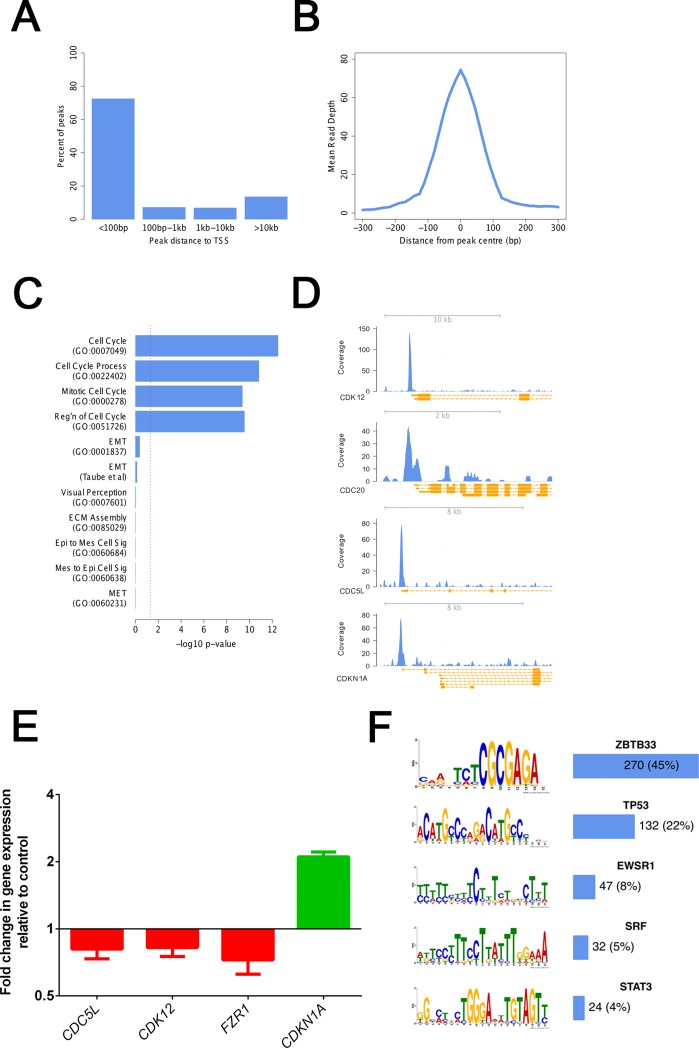
FOXM1 binds to promoters of proliferation associated genes.A. Percentage of FOXM1 peaks within proximity boundaries to Transcription Start Sites (TSS). B. Plot showing the mean read depth over FOXM1 peaks with a majority of binding within 100bp of peak centres. C. Protein coding genes with a FOXM1 peak within 1kb of TSS are highly enriched for GO categories relevant to cell cycle related functions but not EMT, MET, epithelial or mesenchymal related functions. In addition to the GO category, enrichment was also tested at a published EMT gene signature [55] with no significant binding seen. Enrichment was calculated using a hypergeometric distribution, the—log10 p-value is shown. Dashed line represents p = 0.05. D. Schematic showing FOXM1 binding to the promoters of representative cell cycle genes; CDK12, CDC20, CDC5L & CDKN1A. ChIP-seq coverage is shown in blue and annotated genomic features shown in orange. E. Quantification of change in transcript expression of representative FOXM1 bound genes, measured by qPCR, upon siRNA mediated FOXM1 knockdown (relative to transfection with non-targeting siRNA used as a control), 72h post transfection. ACTB is used as a housekeeping gene. Bars represent Mean + SD (n = 3). P<0.05 (Student’s t-test). F. Significantly enriched transcription factor motifs in FOXM1 peaks alongside frequencies of occurrence.